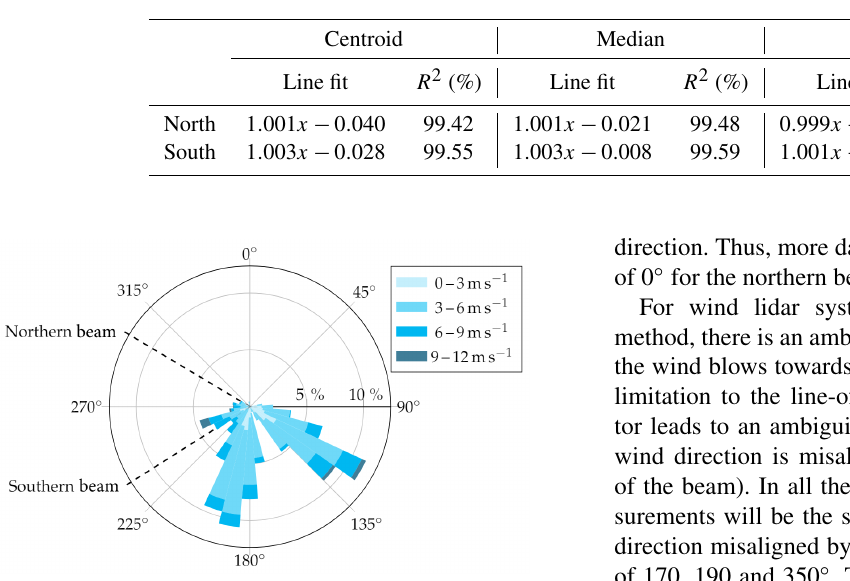
Table 1. Parameters of the line fit to the 10min correlation between the sonic radial component and lidar.